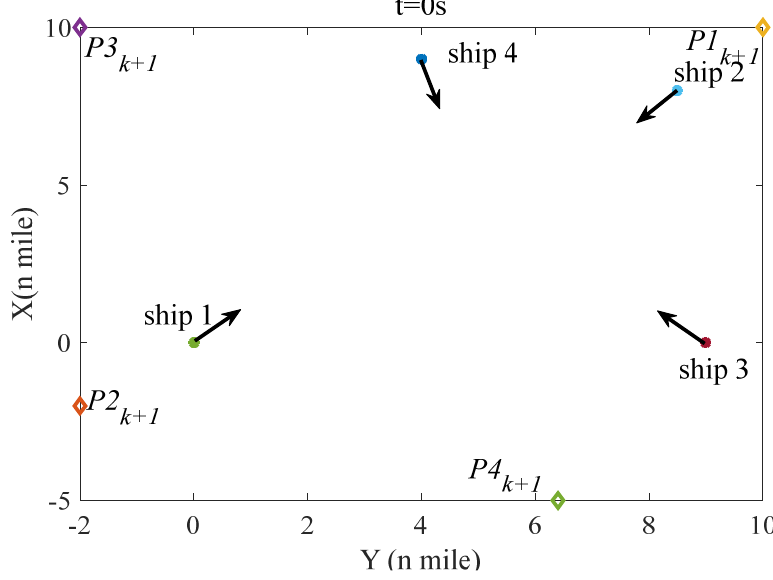
Figure 18. The initial situation of four ships in scenario 3 .